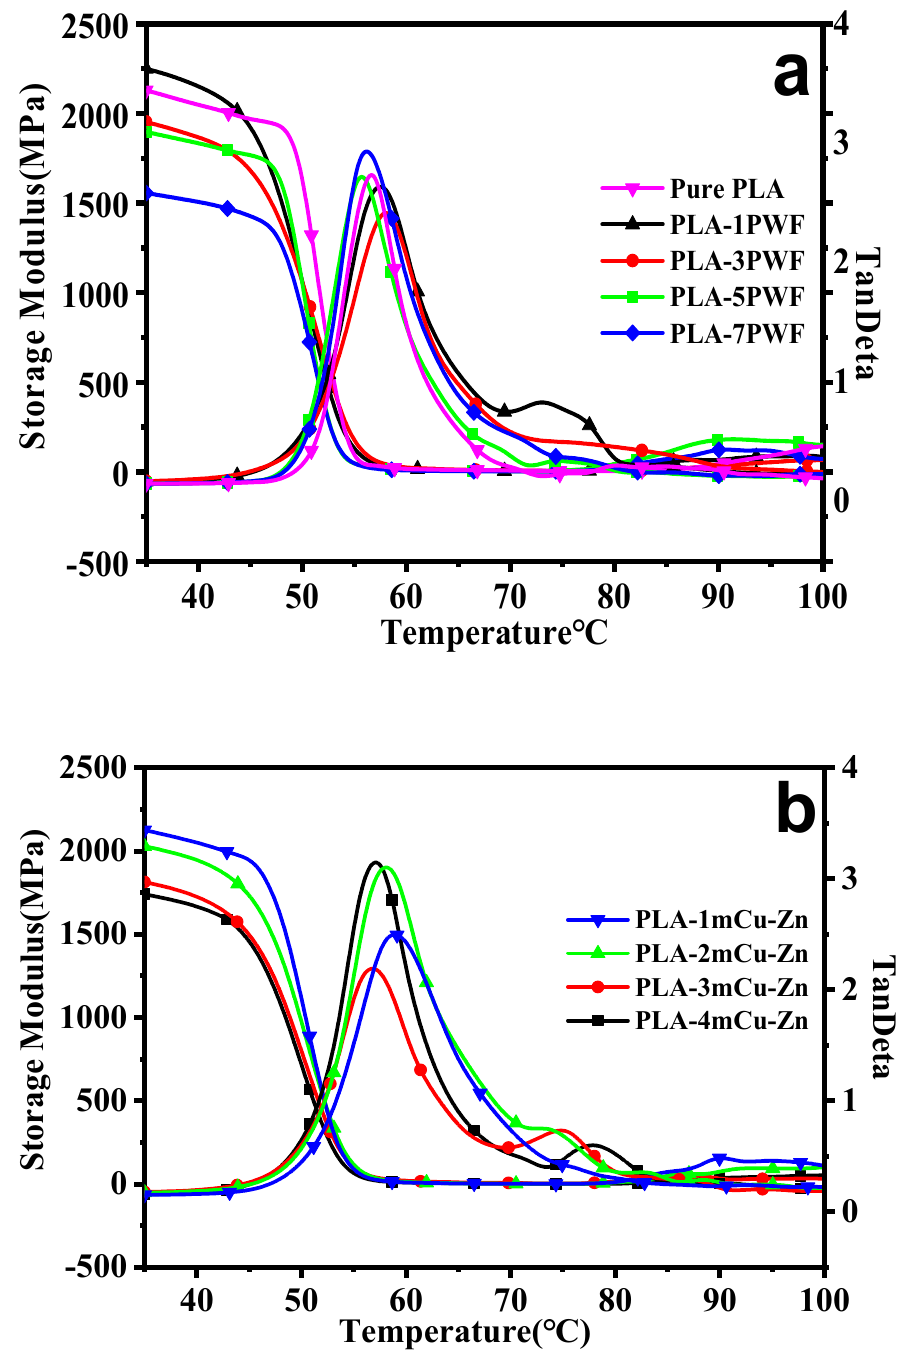
Figure 7. Dynamic mechanical thermal analysis ( DMA) curves of PWF/PLA composites ( a ) and mCu ‐ Zn/PWF/PLA composites with 5 wt.% PWF ( b ). Table 3. DMA and TGA data of PWF/PLA and mCu ‐ Zn/PWF/PLA composites.